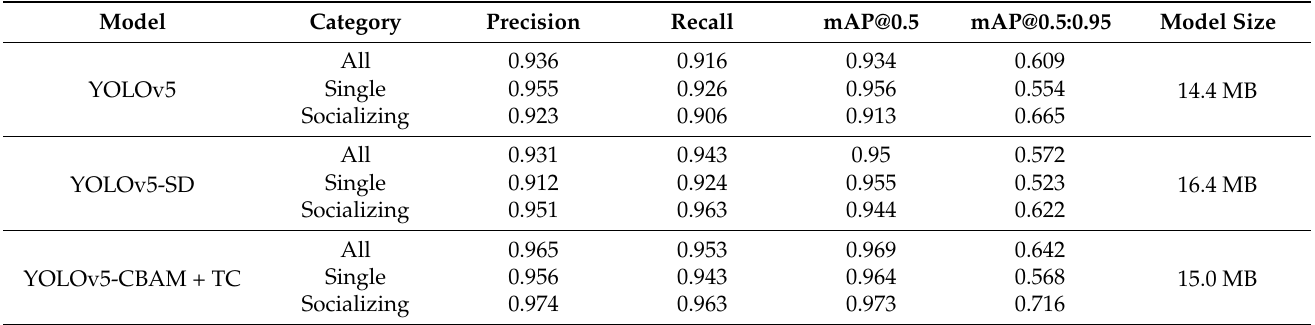
Table 3. Experimental information of the three models.